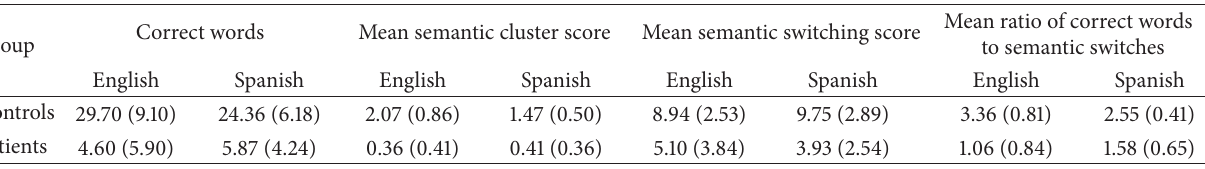
Table 4: Mean correct words on the category generation task, mean semantic cluster scores, and mean semantic switching scores for bilingual normal controls and bilinguals with aphasia (standard deviations are in parenthesis).